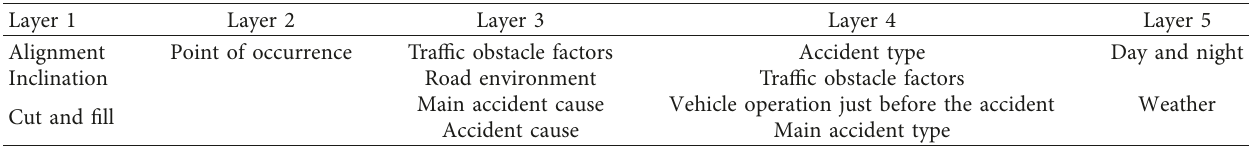
Table 2: Triggering conditions related to-traffic situations.